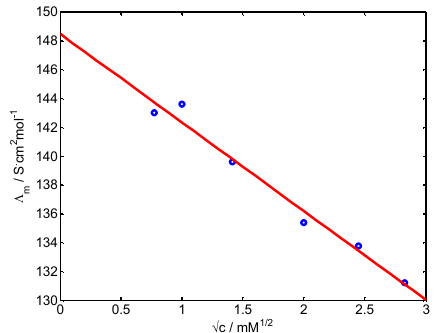
Fig.10: Molar conductivity of KCl with varying concentration. The conductivity in the frequency range of the confidence region was corrected by the conductivity of pure water ( (cid:78) w = 6.41 (cid:80) s/m at 25 o